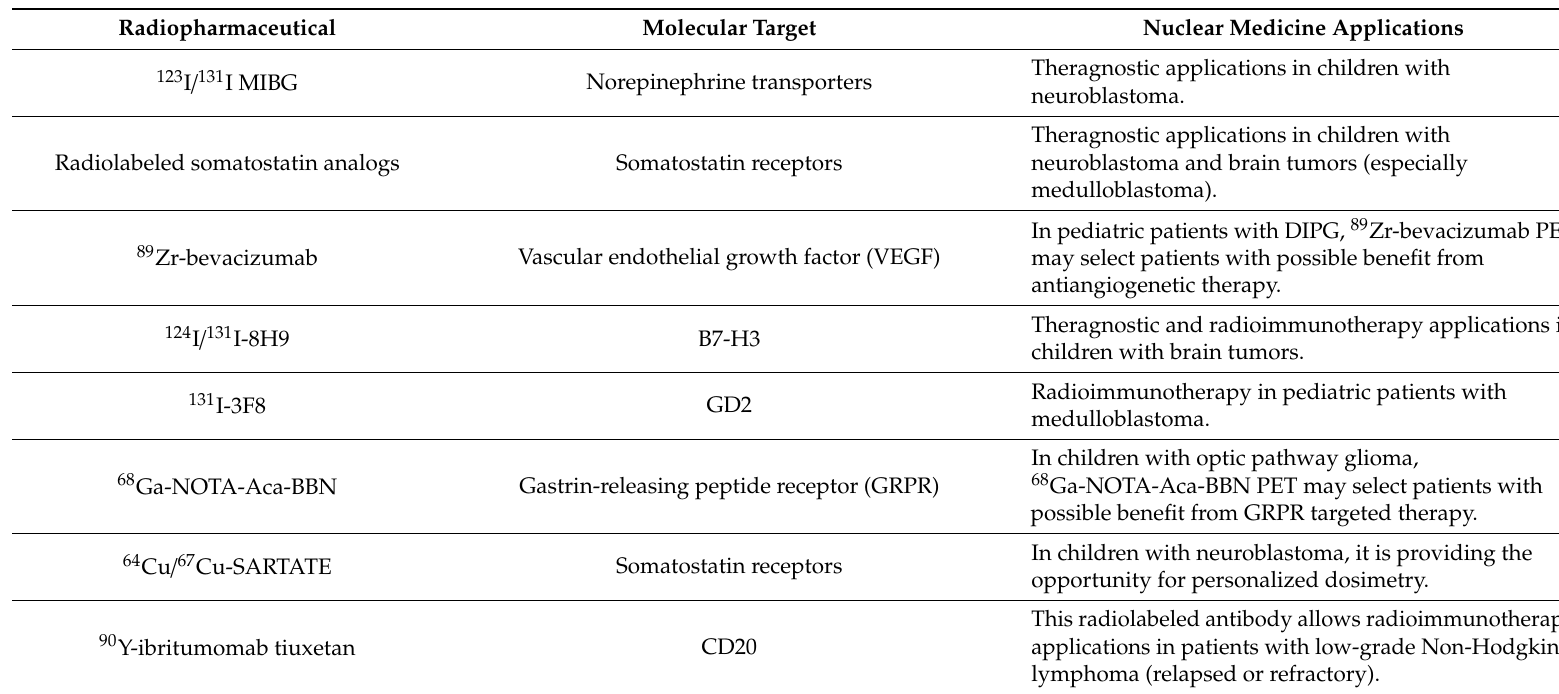
Table 2. Summary of the di ff erent radiopharmaceuticals used for pediatric oncology in theragnostics and radioimmunotherapy, with their molecular